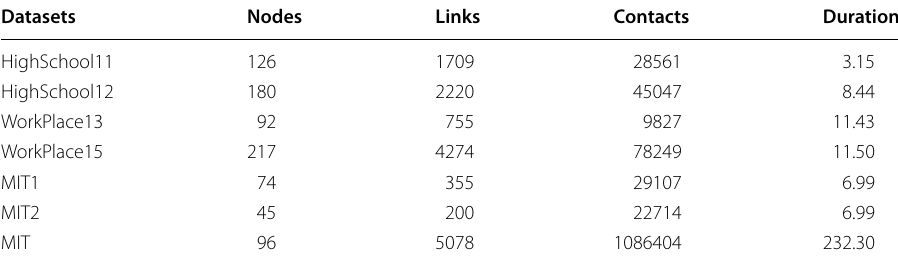
The duration refers to the duration T of the observation window [1,T] in the units of